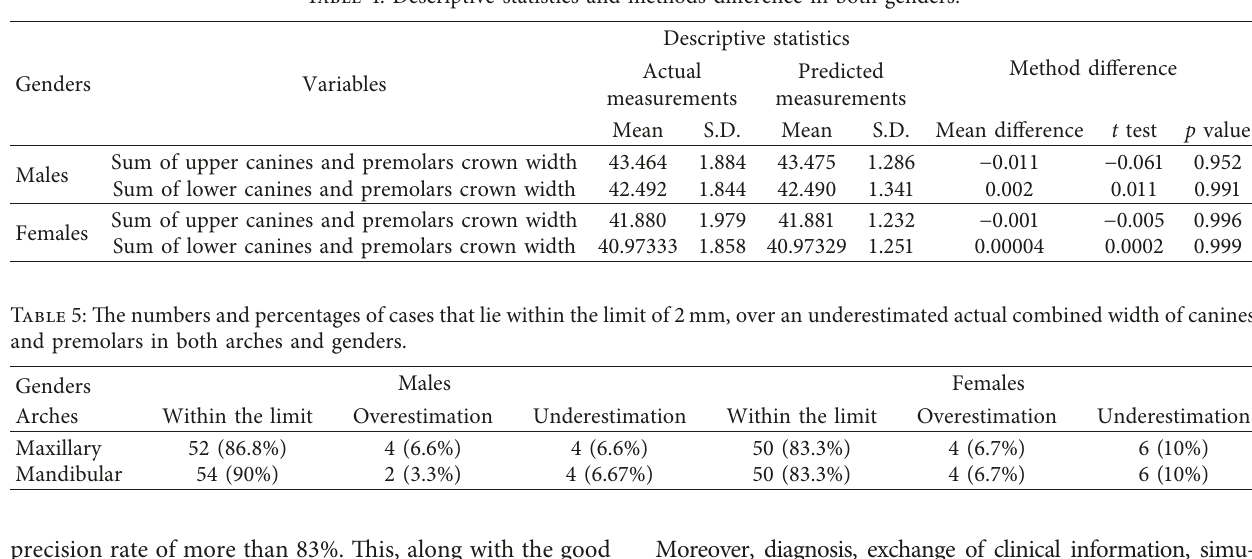
Table 4: Descriptive statistics and methods difference in both genders.